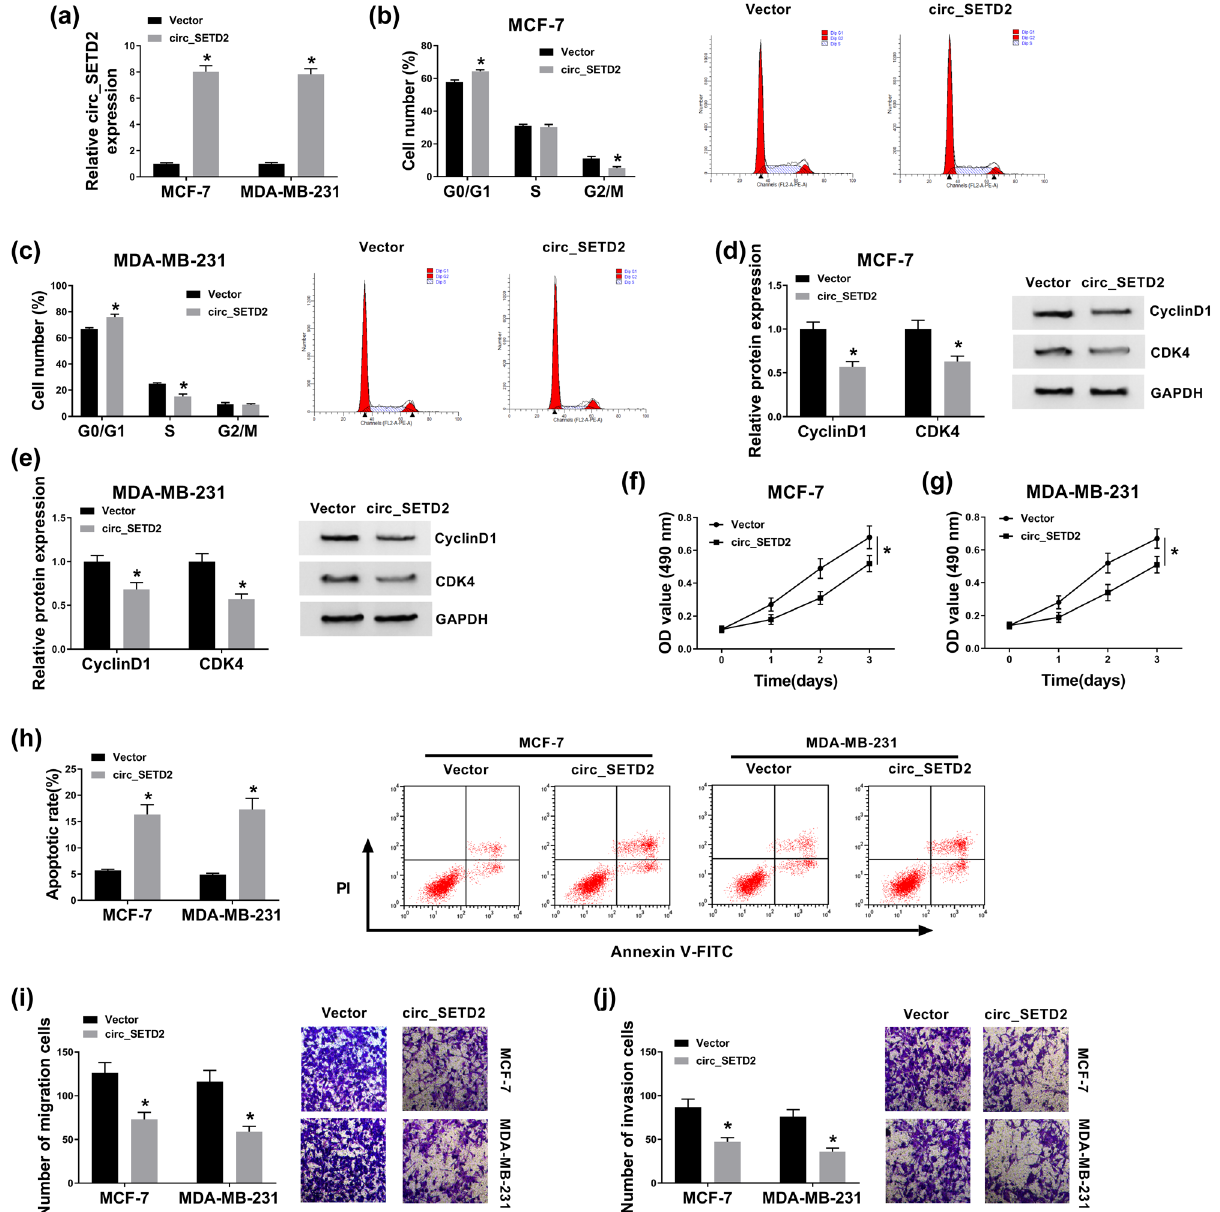
Figure 2: E ff ects of circ_SETD2 introduction on cell cycle, proliferation, apoptosis, migration, and invasion of BC cells. ( a ) qRT - PCR was performed to analyze the expression of circ_SETD2 in MCF - 7 and MDA - MB - 231 cells transfected with circ_SETD2 or vector. ( b and c ) In fl uence of circ_SETD2 overexpression on cell cycle progression of MCF - 7 and MDA - MB - 231 cells was assessed by PI cytometry assay. ( d and e ) Impacts of circ_SETD2 upregulation on the expression of cyclin D1 and CDK4 proteins of MCF - 7 and MDA - MB - 231 cells were evaluated by western blot analysis. ( f – j ) E ff ects of circ_SETD2 elevation on cell proliferation, apoptosis, migration, and invasion in MCF - 7 and MDA - MB - 231 cells were determined with the MTT ( f and g ) , fl ow cytometry ( h ) , and transwell assays ( i and j ) . The data are presented as mean ± standard deviation; one - way ANOVA followed by Tukey ’ s post hoc test was utilized to compare the di ff erences among groups; the experiments were repeated three times. * P <